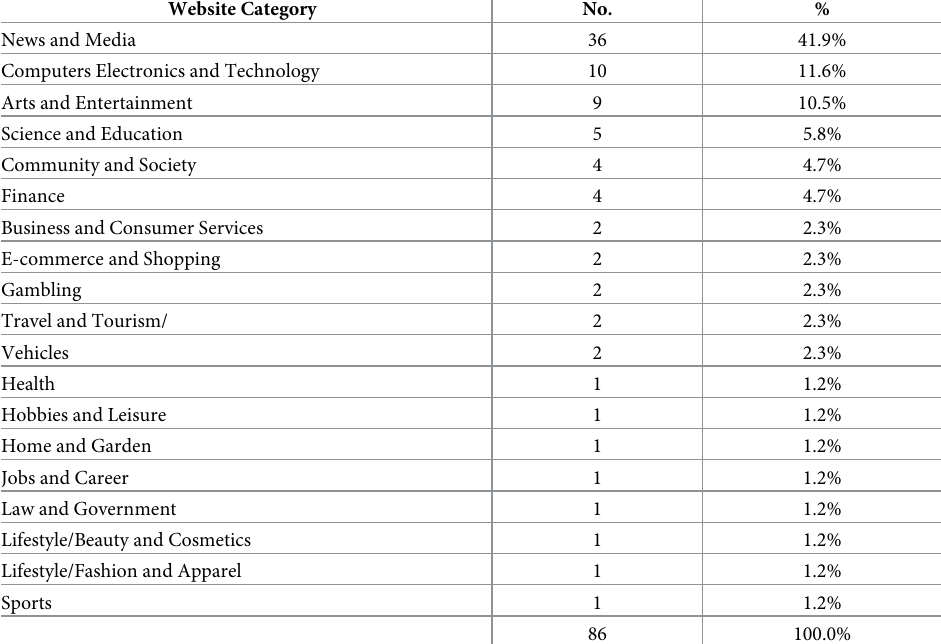
Table 4. Industry vertical of organization for 86 websites in study.